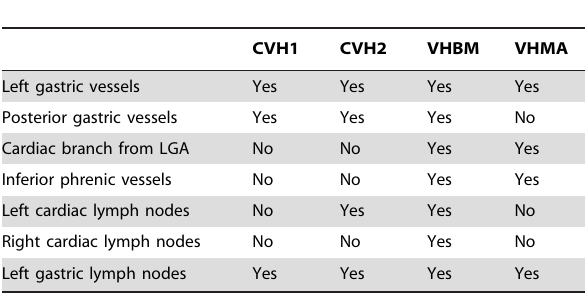
Table 1. Distribution of the internal structures of the